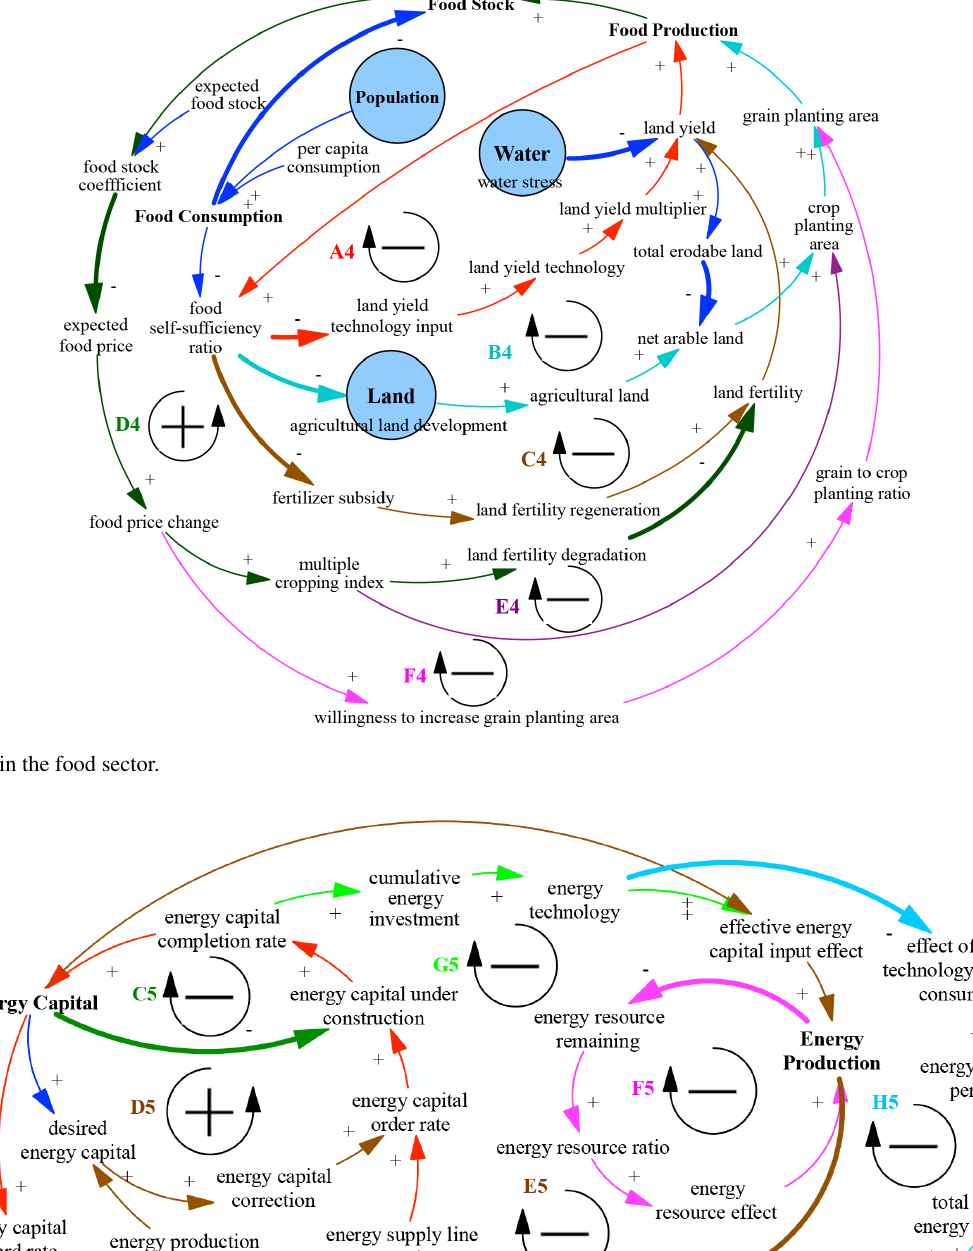
Geosci. Model Dev., 15, 4503–4528, 2022